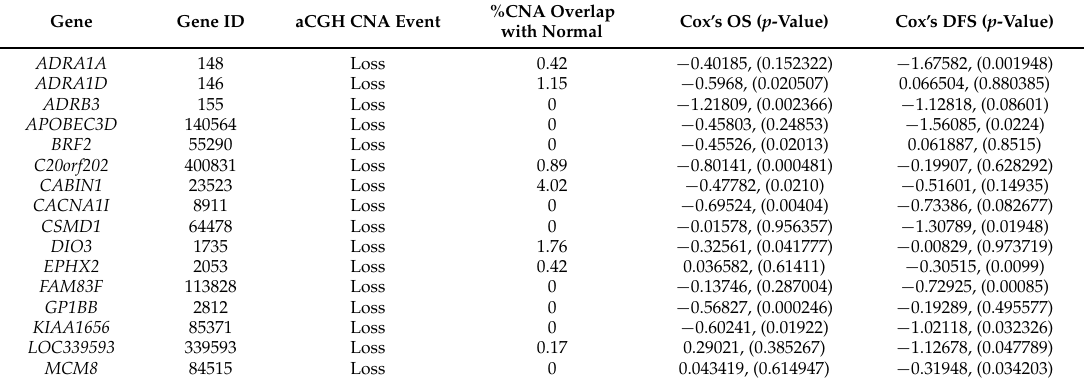
Table 2. Cox regression for survival analysis of the 42 genes’ mRNA expression in meta-cohort (Affymetrix U133A, n = 1820; or U133Plus2, n = 1436) for overall survival (OS), and disease-free survival (DFS). A negative regression coefficient implies a better prognosis for patients if they retain the function of a given gene (worse prognosis when the cancer underexpresses the gene). Conversely, a positive regression coefficient means that the hazard is higher for a given gene’s overexpression and, thus, the prognosis worse.